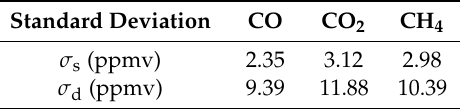
Figure 9. Long-term ( a ) static and ( b ) dynamic measurements of a gas mixture composed of CO, CO 2 and CH 4 concentration levels of 632, 1263 and 1891 ppmv, respectively. Table 1. Comparison of standard deviations between static and dynamic operations of the sensor system, where σ s is the deviation in static state and σ d is the deviation in dynamic state.